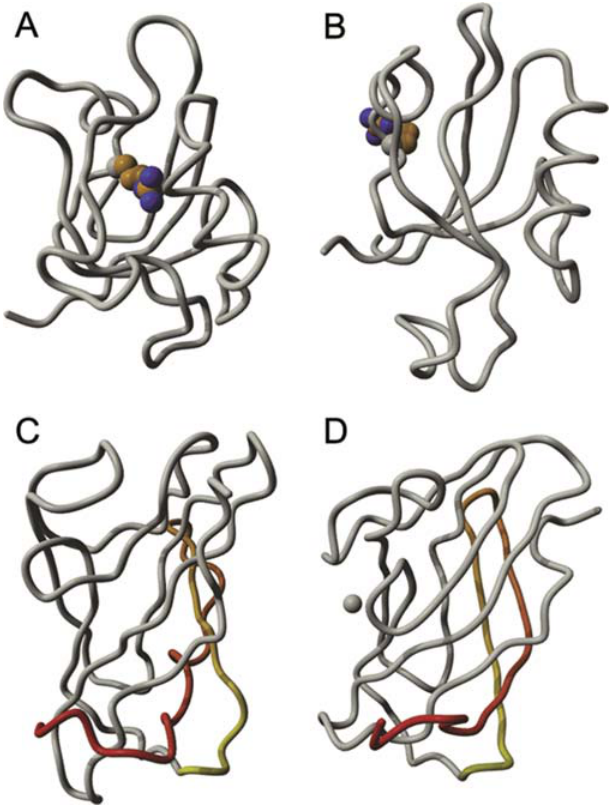
Figure 5. Examples of Observed Structural Anomalies (A) An arginine side chain protruding the hydrophobic core of the second PDZ domain of PTP-Bas [39]. (B) The corresponding arginine in the highly homologous second PDZ domain of PTP-BL [37] is solvent exposed. (C) The C-terminal region of DR1885 [42] (residues 120 to 149 are color- coded from yellow to red) forms a knot-like structure in the apo-form of DR1885. (D) In the copper bound form of DR1885, the C-terminus wraps around the protein, instead of traversing through it. For each of the four structure ensembles, only the first, and presumably best, model is shown. DOI: